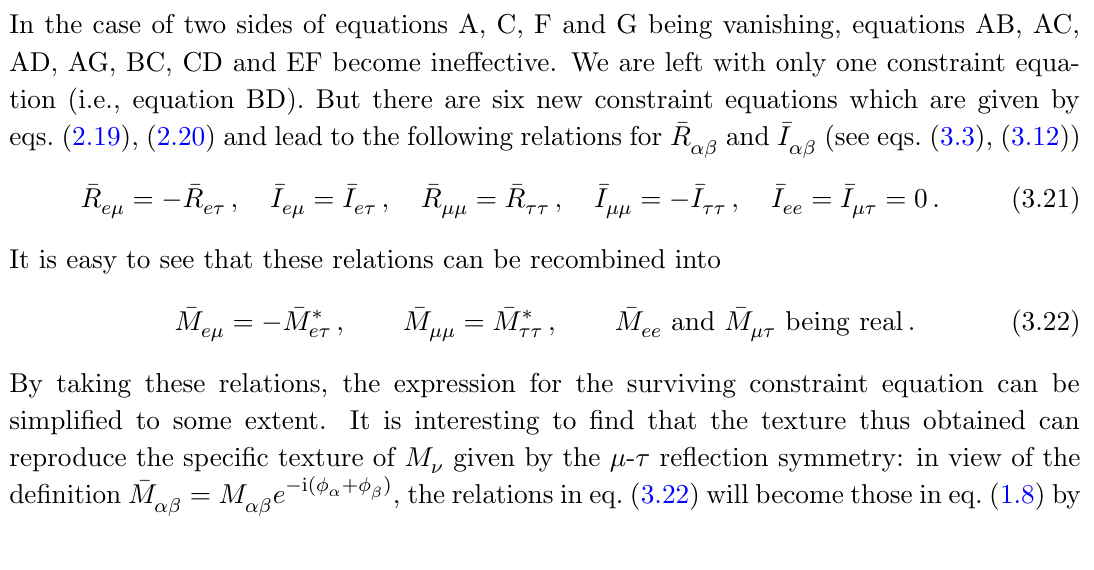
Figure 5 . (cid:26) , (cid:27) and jh m i of equations A, B and G being